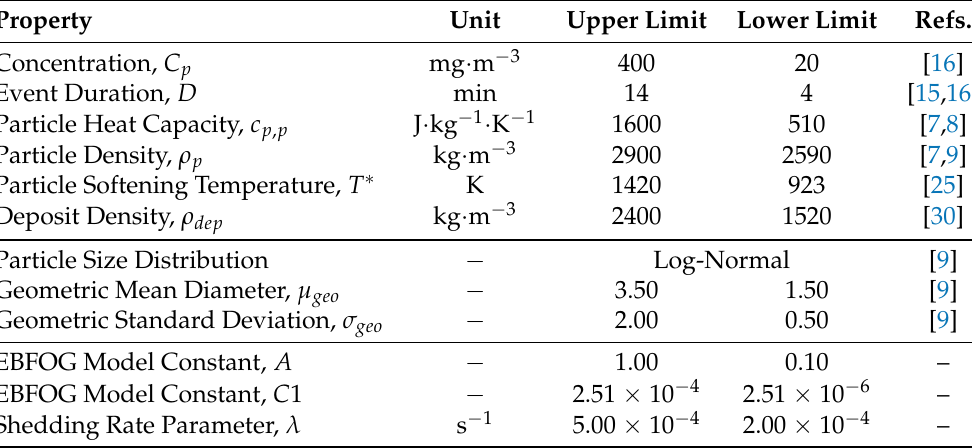
Table 2. Dust property ranges for the basaltic ash encountered during the 1985 Mount Soputan